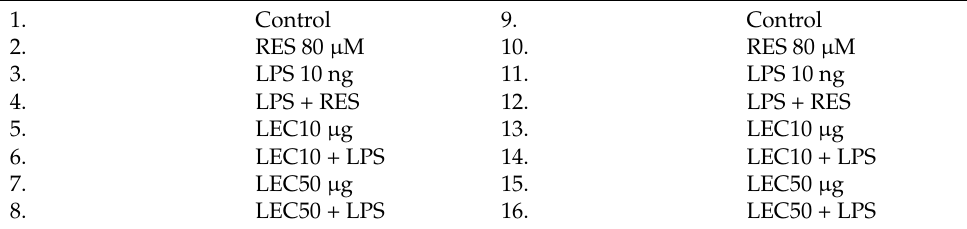
Table 4. Treatments for PBMCs from non-diabetic controls and